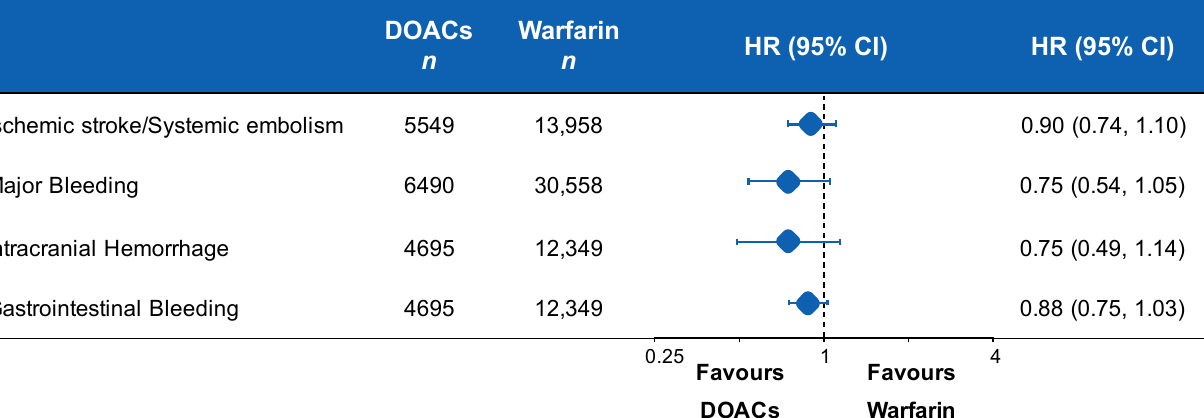
Figure 8. DOACs vs. warfarin in non-valvular AF patients with advanced kidney disease or undergoing dialysis.